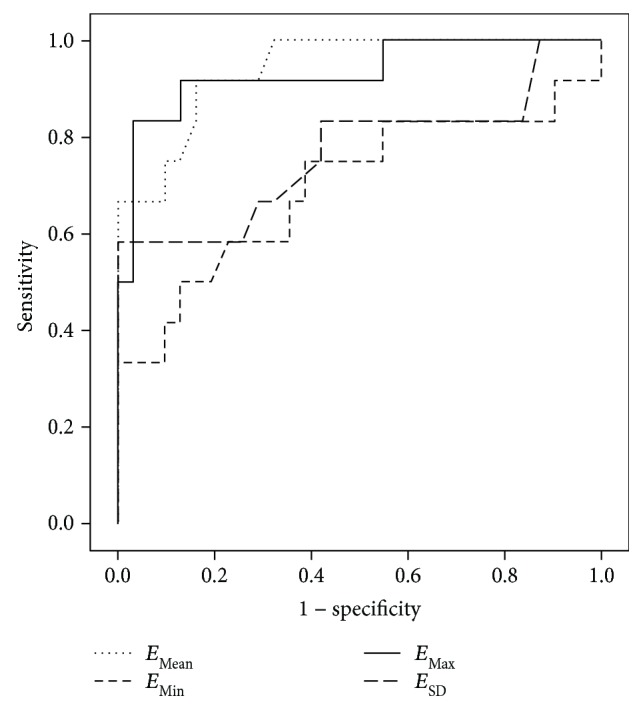
Receiver operating curves of EMean, EMin, EMax, and ESD for predicting malignant LNs.